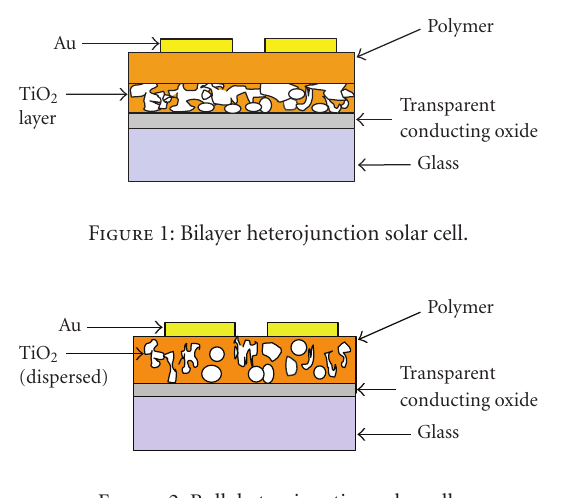
Figure 2: Bulk heterojunction solar cell.